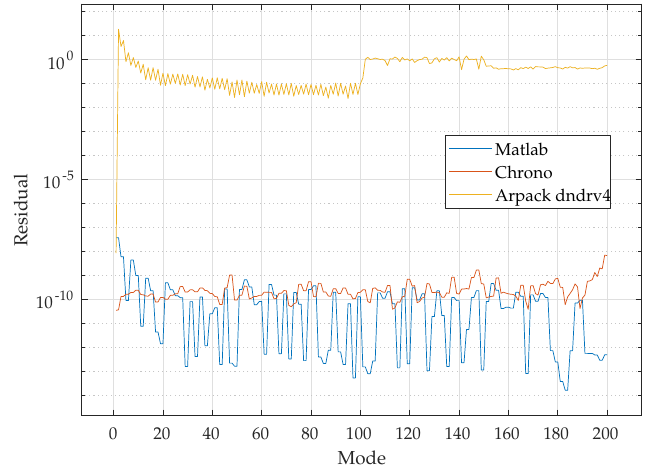
Figure 6. Residuals of 20 × 14 grid